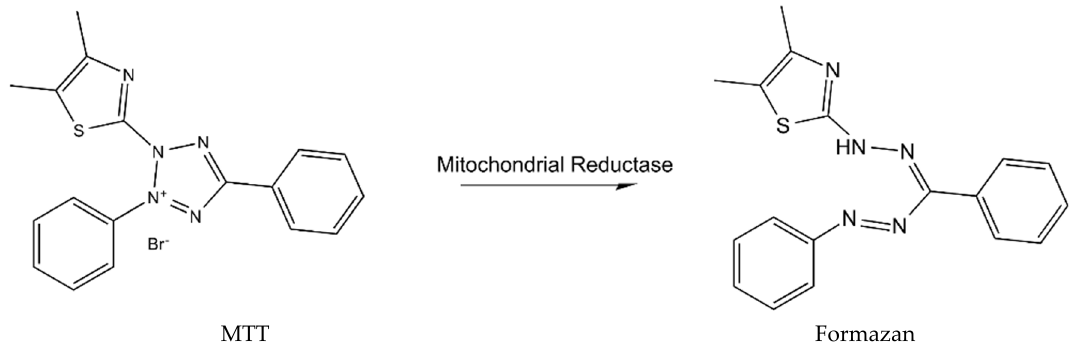
Figure 3. The reaction describing MTT procedure (metabolism of MTT to a formazan salt).